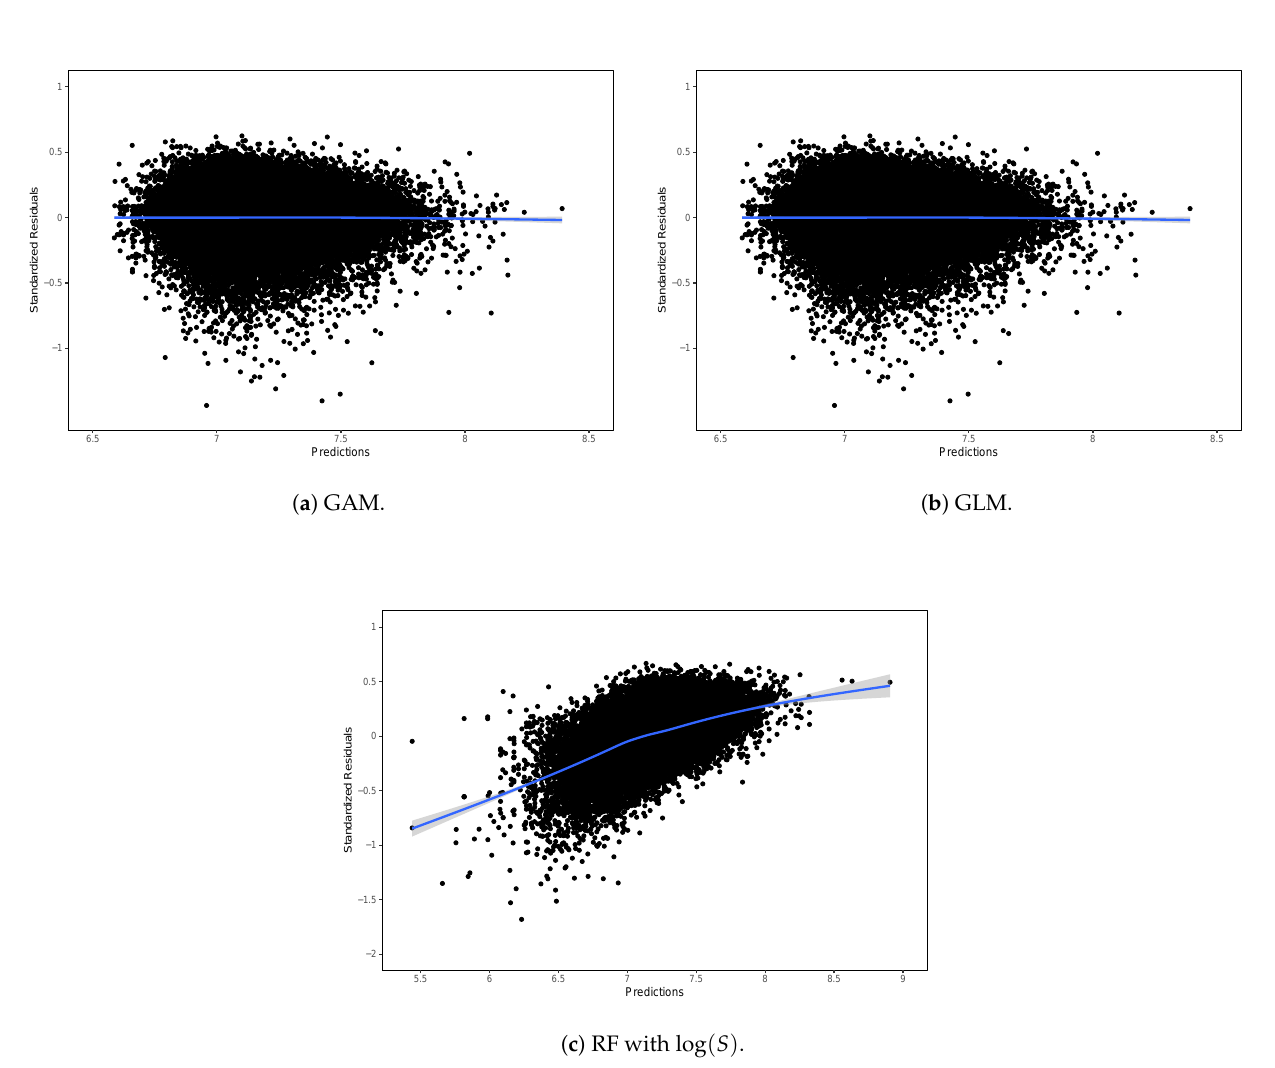
Figure 8. Illustration of the residuals and the predictions for the models using log S .